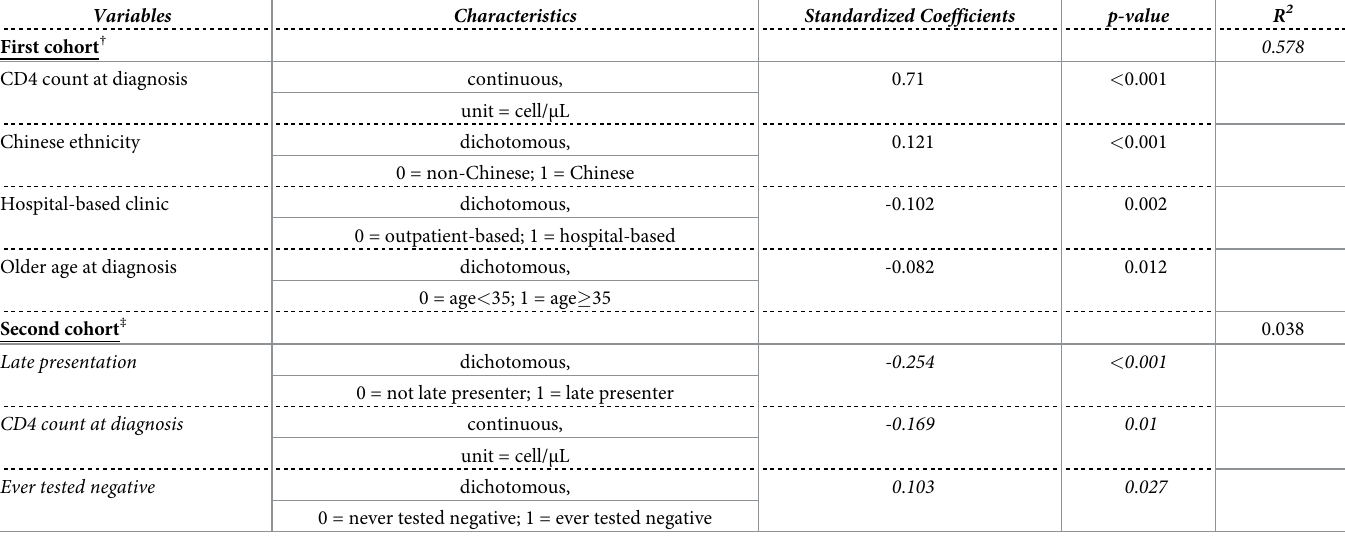
Table 2. Factors associated with number of days between diagnosis and antiretroviral therapy initiation of MSM and heterosexual patients in multivariable linear regression models.